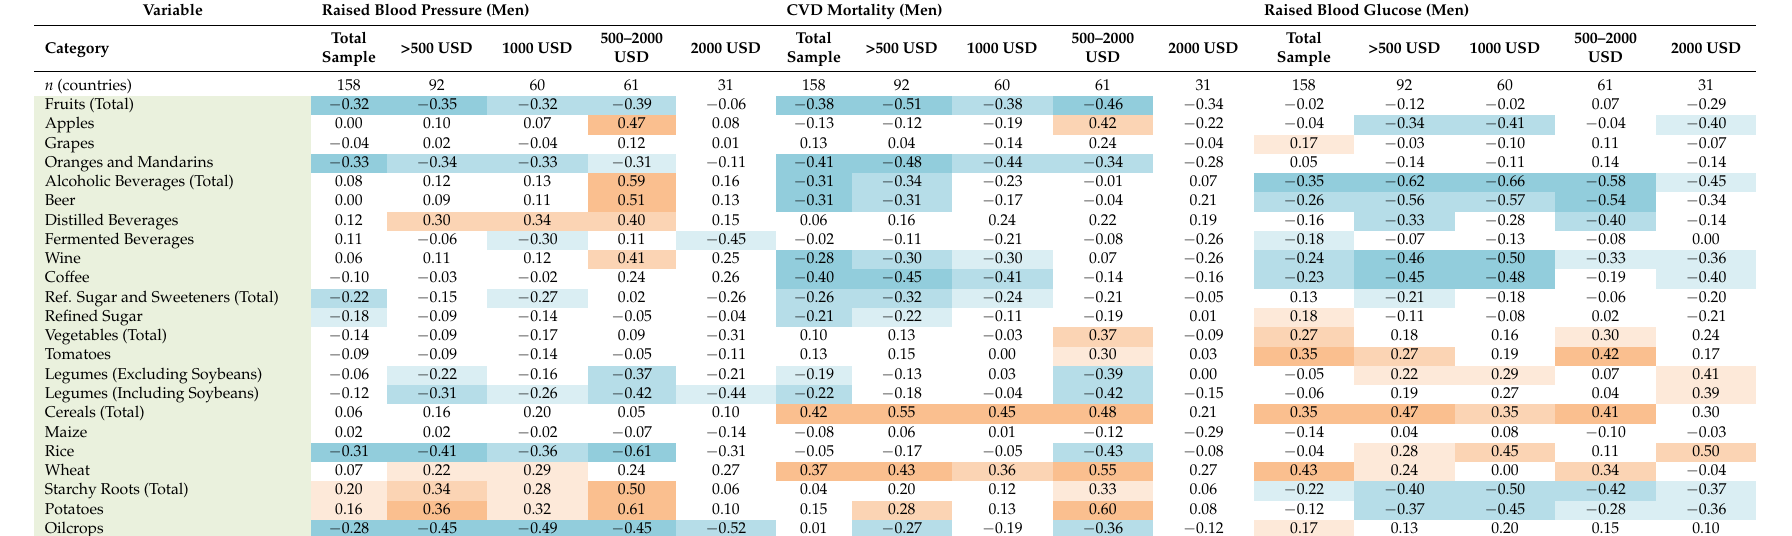
Table 4. Pearson linear correlations in men: differences according to health expenditure per capita (constant 2011 international USD,